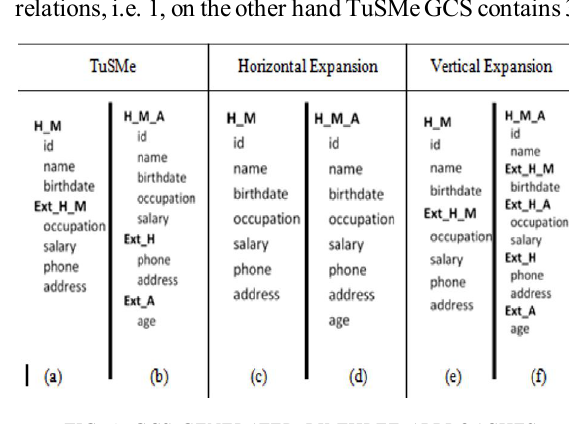
FIG. 4. GCS GENERATED BY THREE APPROACHES TABLE 1. FACTS ABOUT DATA IN MEMBER